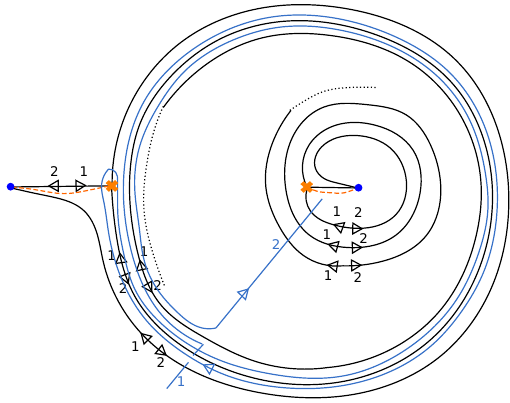
Figure 76 . One of the lifts contributing to F (cid:0) ([ l ]) (12) . This speci(cid:12)c lift contributes (cid:0) q w 12 (cid:0) 3 2 X